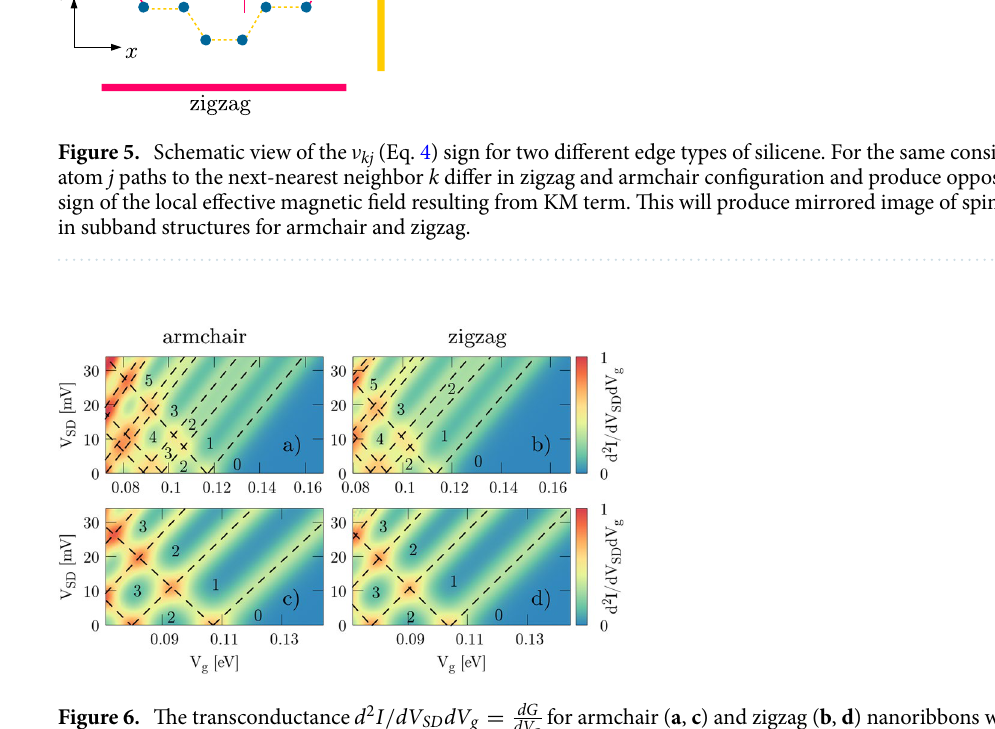
dG dV g for armchair ( a , c ) and zigzag ( b , d ) nanoribbons with =